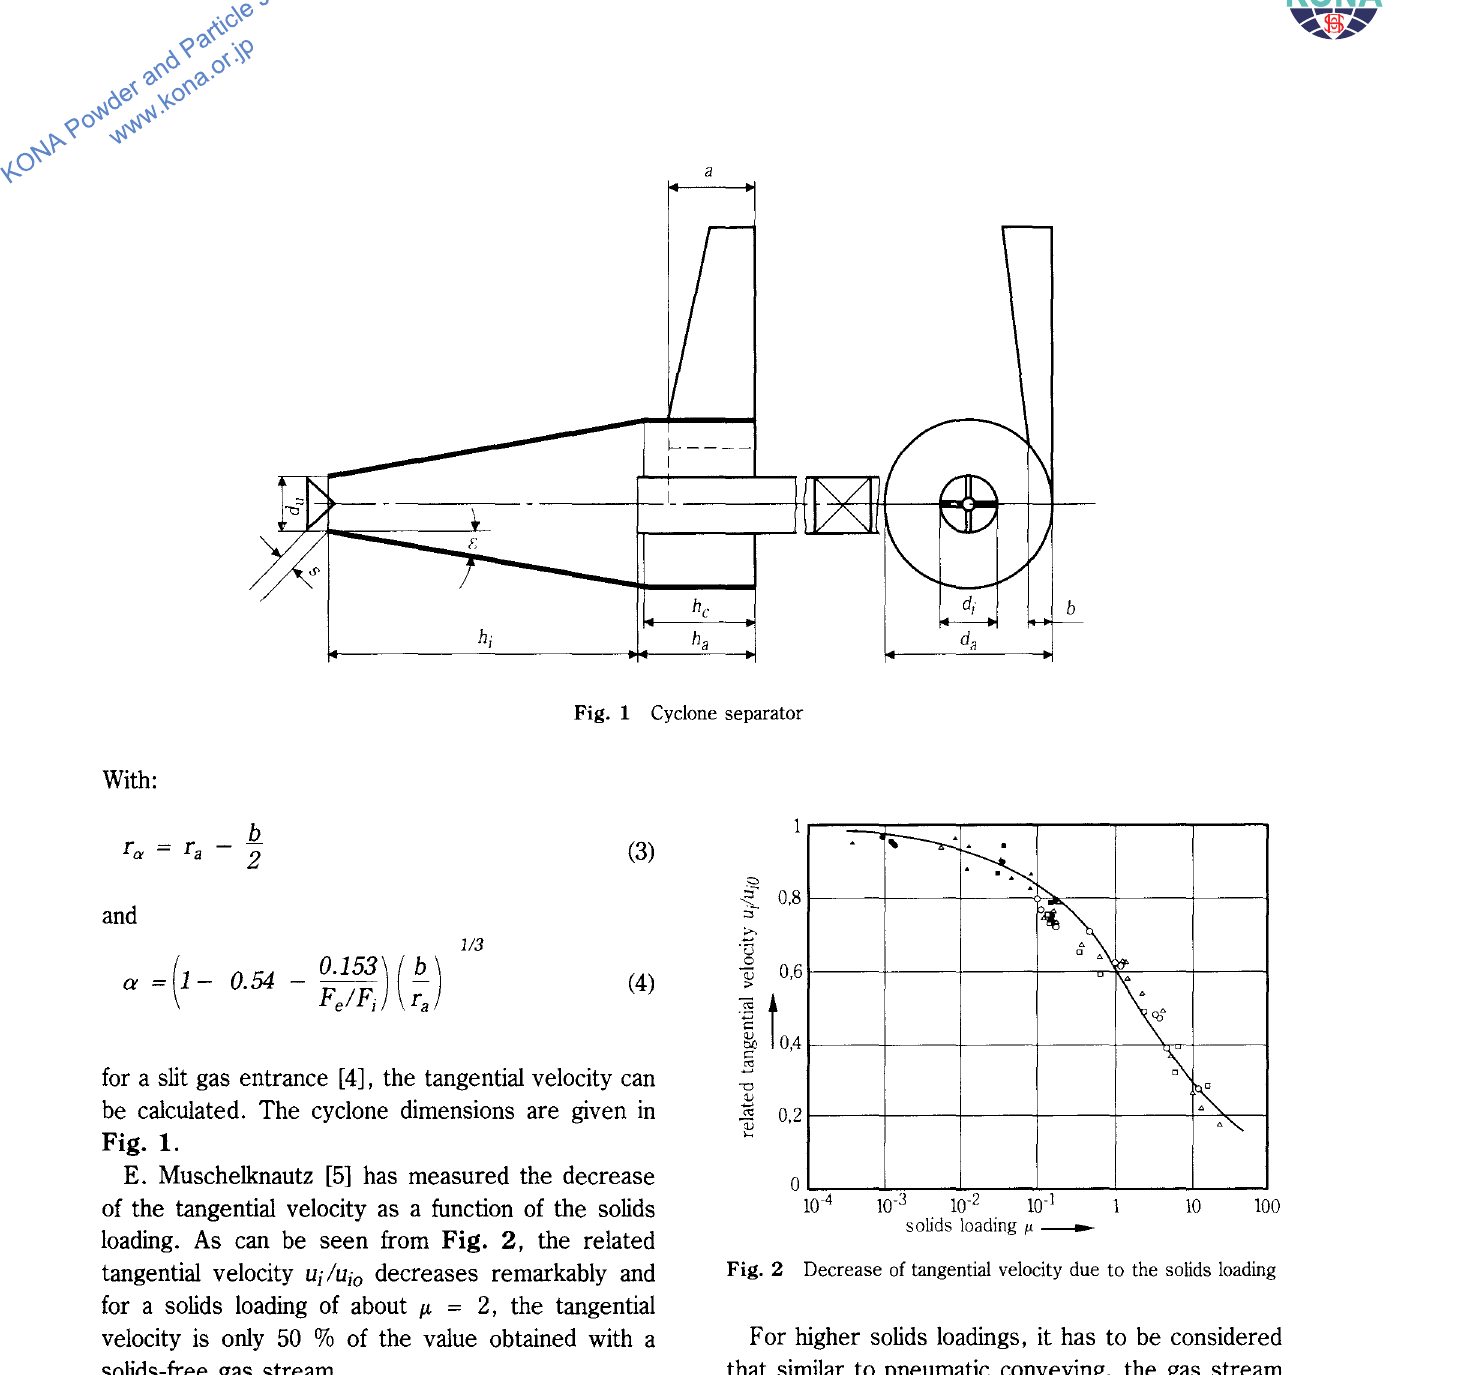
Fig. 2 Decrease of tangential velocity due to the solids